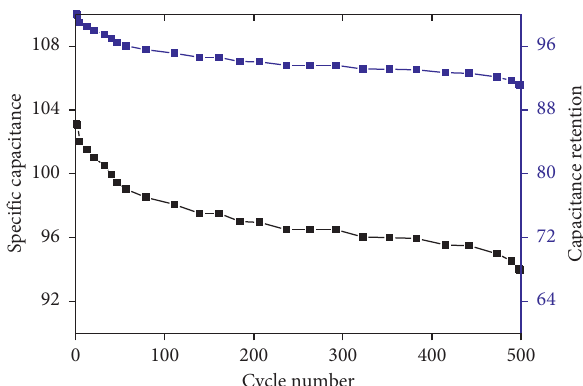
Figure 10: The capacitance and the capacitance retention in the relation of the cycling number for the PANI/GO/Azo composite (no UV irradiation)